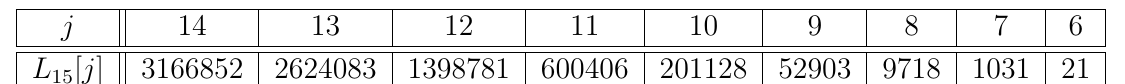
Table 6: Number L [ j ] of forcibly connected graphical degree sequences of length 15 with 15 given largest term j